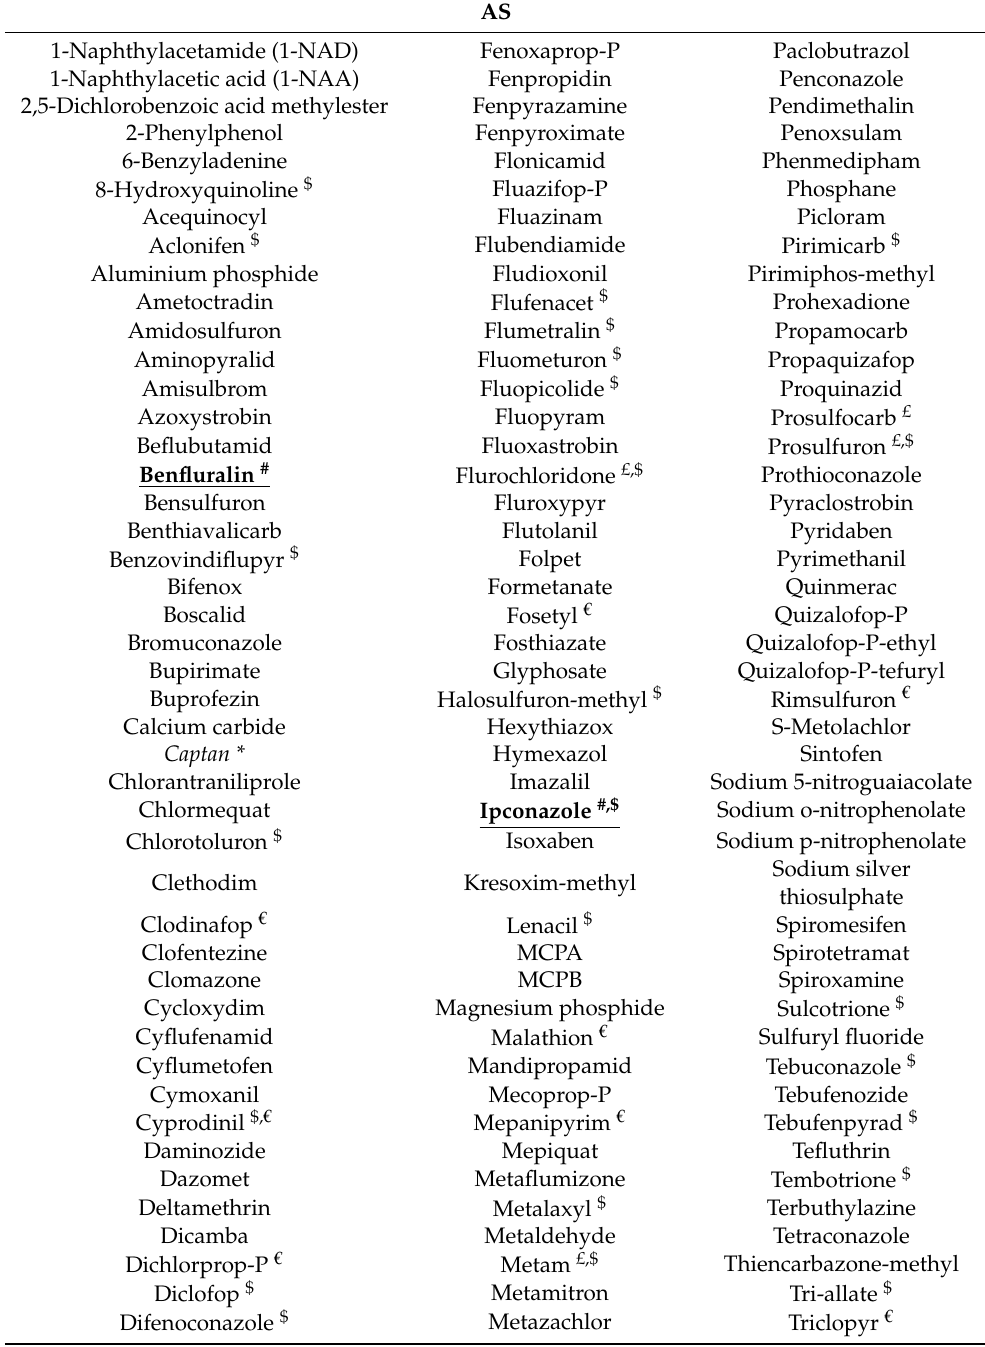
Table 5. Chemical AS with end of approval year in 2023 or